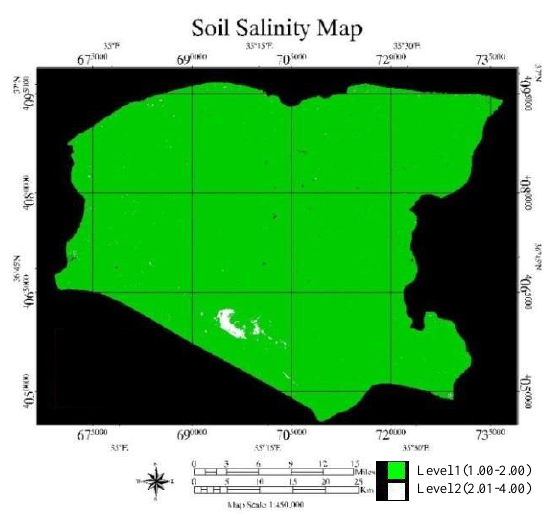
Figure 5. Soil salinity map according to global standard salinity ranges.